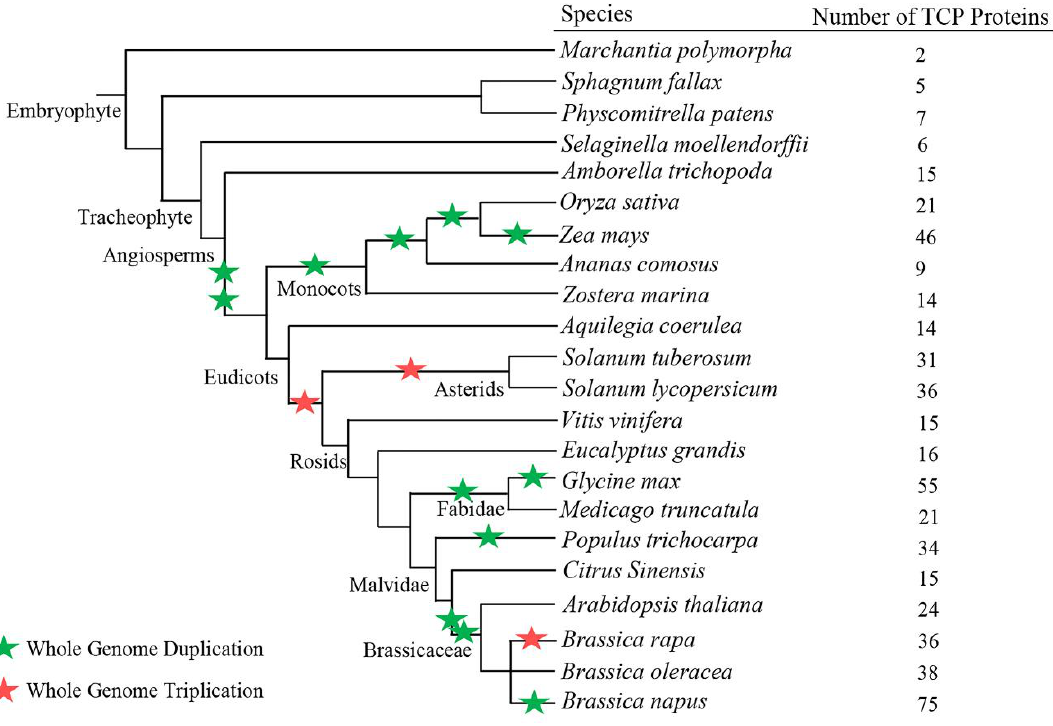
Phylogenetic relationships and total number of TCP (Teosinte-branched 1 / Cycloidea / Proliferating) genes for all species investigated in this study with TCP proteins. Phylogenetic relationships among these species have been described in Phytozome (http://www.phytozome.net/) [28]. Green stars indicate whole genome duplication; the red star denotes whole genome triplication (http://chibba.agtec.uga.edu/duplication/).